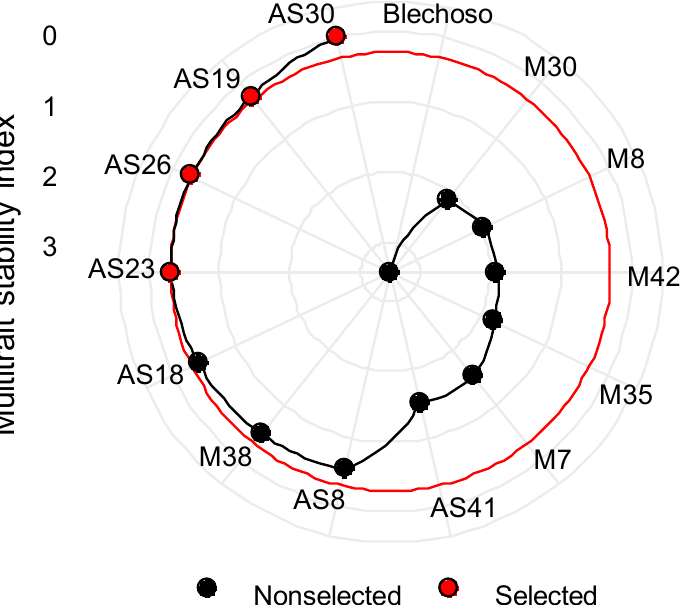
Figure 4. Ranking of accessions based on MTSI index for GY and ascochyta infection assigning a selection intensity of 25/75 (25% stability, 75% performance).